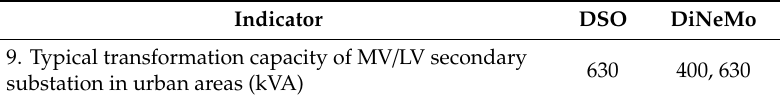
Table 4. Typical transformation capacity comparison for city